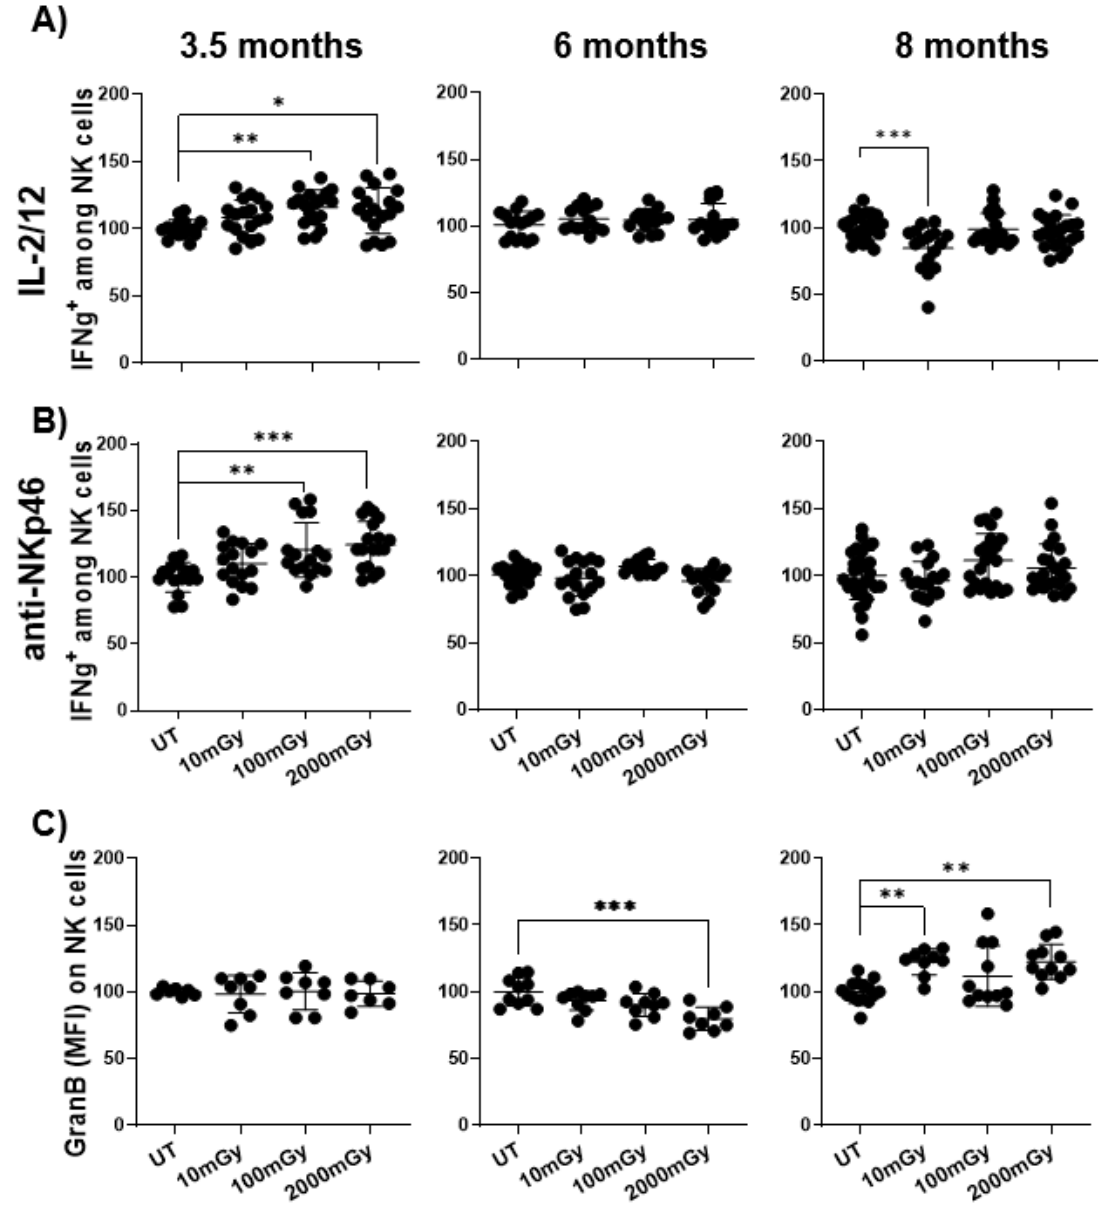
Figure 5. LDR enhances immune cell function. Splenic lymphocytes isolated from mice sacrificed at indicated time points after radiation exposure were stimulated with either ( A ) IL-2 and IL-12 or ( B ) anti-NKp46 for 5 h followed by intracellular staining and flow cytometry to measure IFN γ positive cells in the NK cell population. ( C ) Intracellular staining of splenic lymphocytes was performed to measure expression of Granzyme B in NKp46 + DX5 + NK cells by flow cytometry. To measure IFN γ , the experiment was performed in triplicate. Y-axis in ( A ) represents the relative percent of IFN γ + NK cells and ( B ) represents the relative MFI of Granzyme B staining on NK cells. Percent cells and MFI in untreated mice were set to 100%. Data represent mean + SD. * p < 0.05, ** p < 0.01, *** p < 0.001.